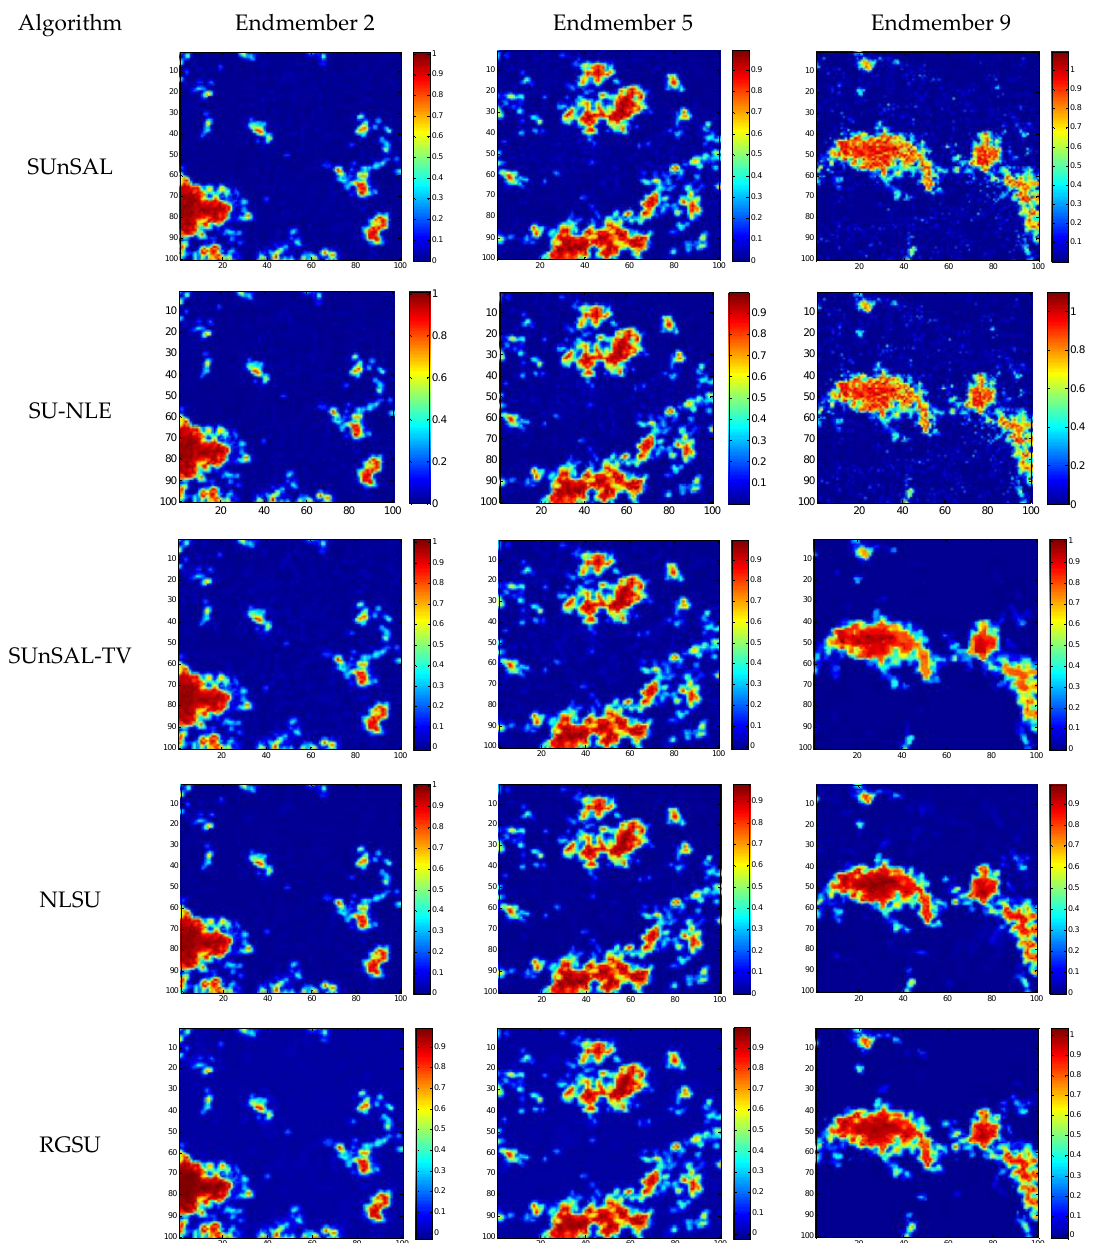
Figure 8. Estimated abundances of endmembers 1, 2, and 5 for simulated dataset 2.